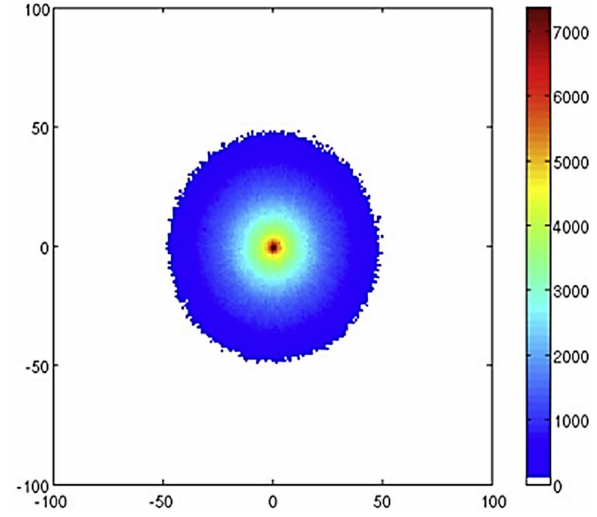
Figure 7. Number of photons emitted per mm 2 attributed to the 337 nm emission in a 200 × 200 mm area as observed from above a 241 Am source dispersed over a 2 cm radius circle on an aluminium surface. The ticks give the x and y positions in mm. Reprinted from [20] with permission from